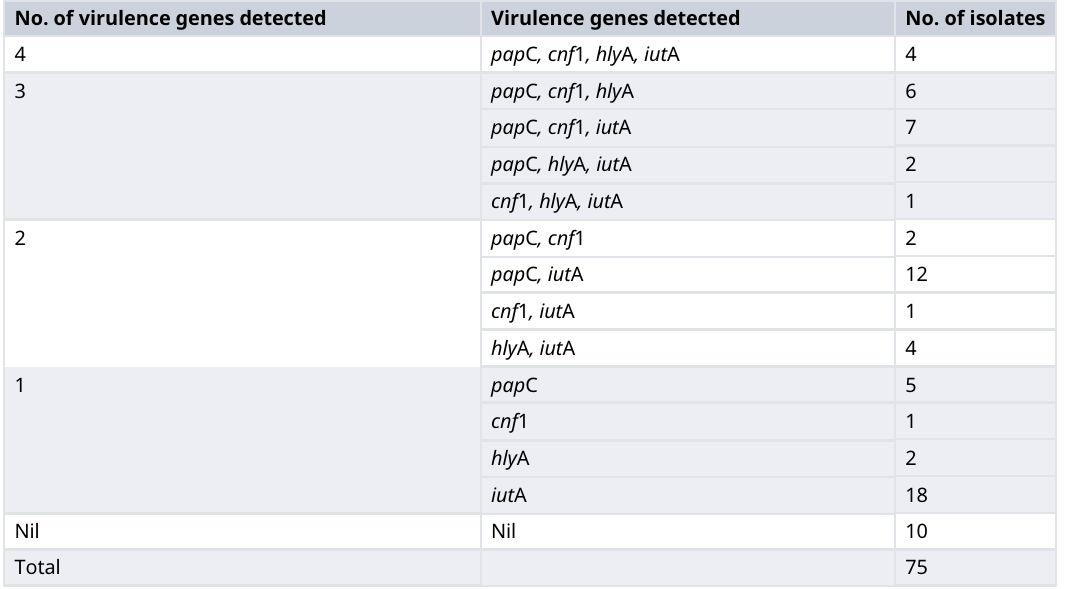
Table 3. The spectrum of virulence genes detected in UPEC isolates.